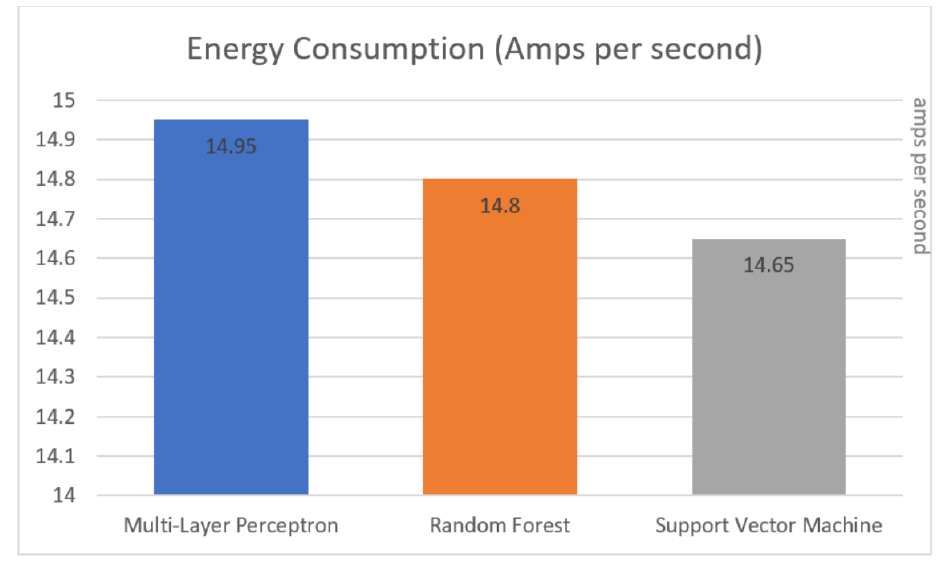
Figure 10. Algorithm energy consumption comparison.